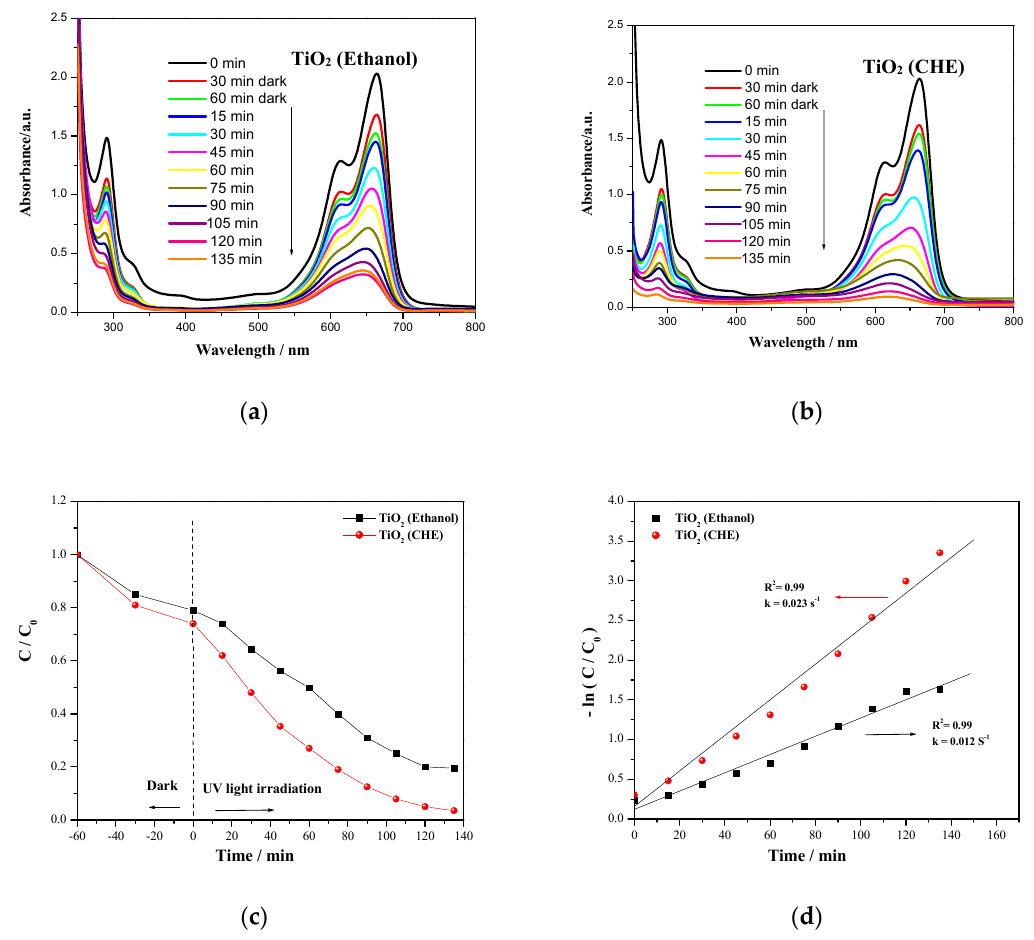
Figure 7. ( a , b ) UV-vis absorption spectra of an aqueous solution of MB during solar light illumination in the presence of the as synthesized TiO 2 (ethanol) and TiO 2 (CHE), respectively; ( c ) efficiency of the photocatalytic degradation of MB as the variation of C/C 0 with irradiation time in the presence of various nanomaterials; ( d ) linear plots of – ln C/C 0 vs. time for the experimental data in Figure 7c.